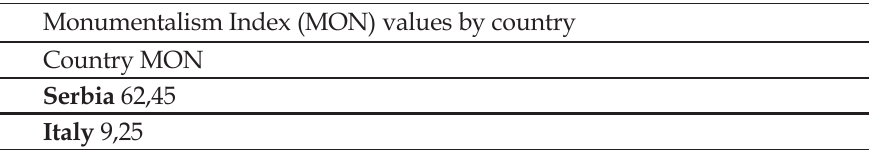
Table 8. Monumentalism Index (MON) values by